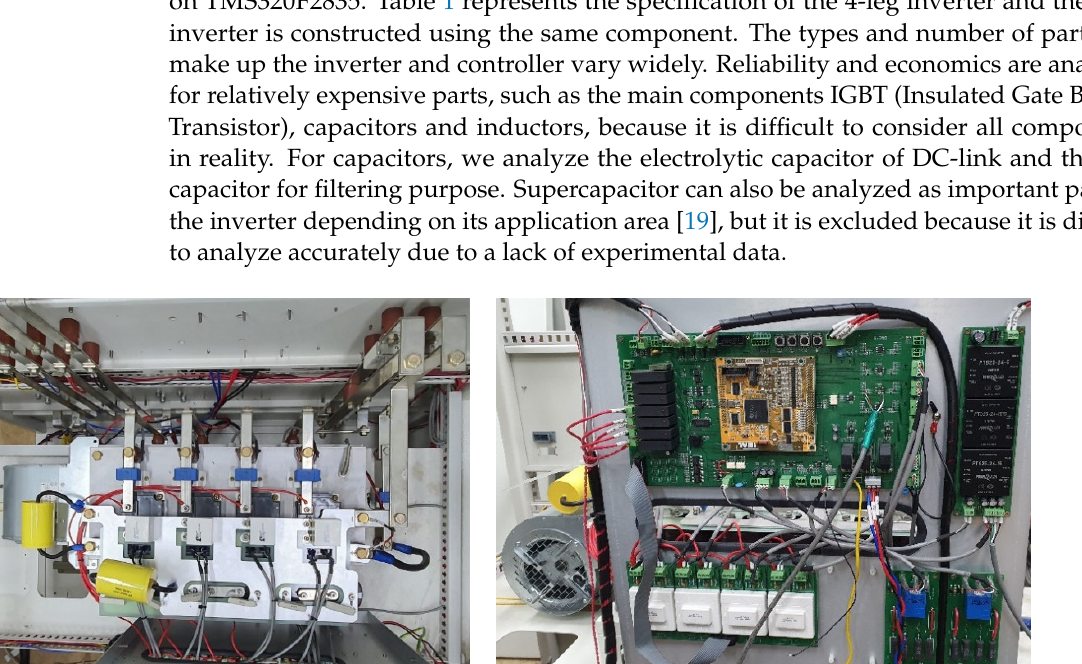
Figure 3. Circuit configuration of three-phase 4-leg inverter.